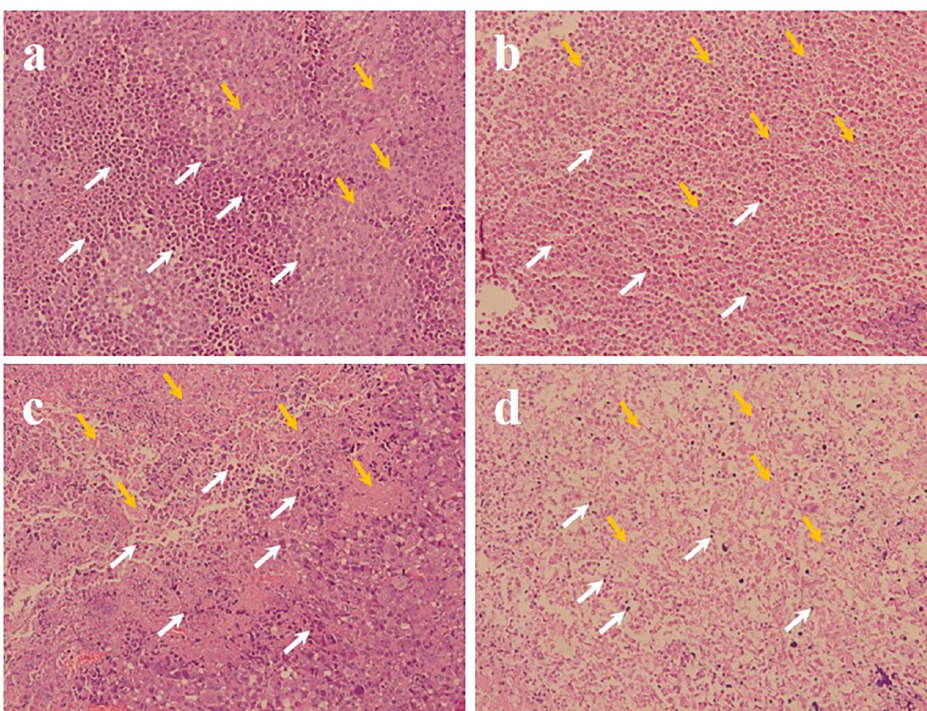
Figure 8. Histological analysis of mouse tumor sections: ( a ) PBS control group, ( b ) free DOX group, ( c ) PDNPs group, and ( d ) mAb-CD163-PDNPs group. White arrows indicate tumor cells and orange arrows indicate cell debris.